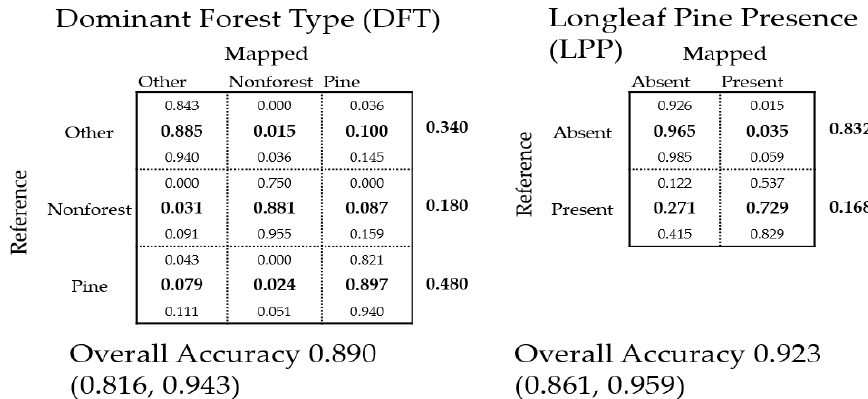
Figure 8. Accuracy assessment for dominant forest type (DFT) and presence of longleaf pine (LPP) using all 244 field plots and the corresponding ensemble generalized additive model (EGAM). Exact 95 percent lower and upper confidence limits for each class are reported above and below bold numbers within the error matrix and within parentheses of overall accuracy.